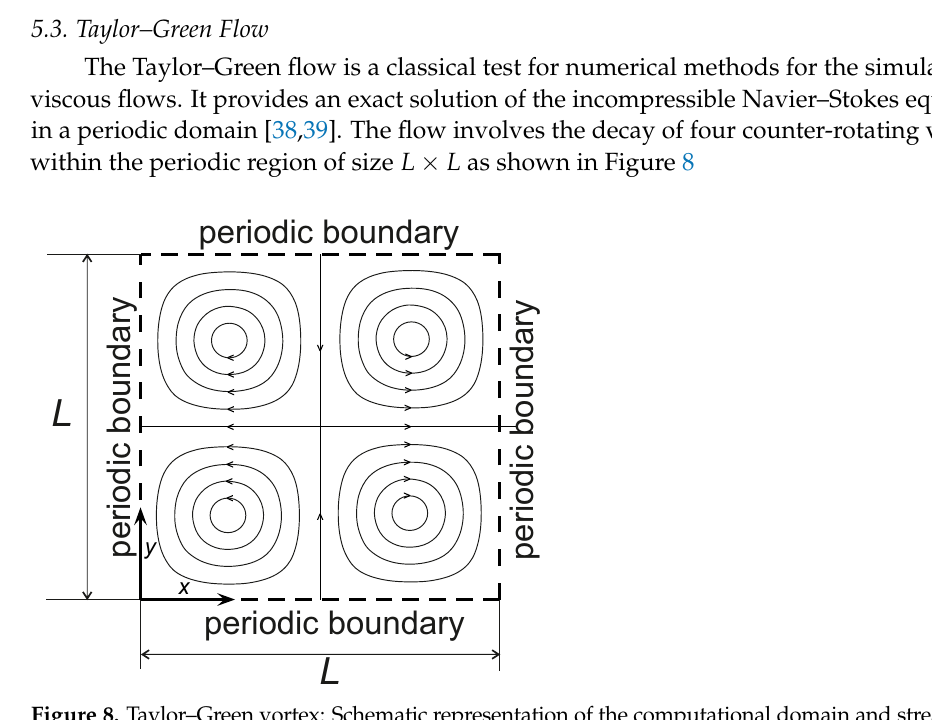
Figure 7. 2D Blast Explosion: Density profile along radial coordinate at time t final = 10 − 5 s. Radial distribution ( top left ), Delaunay distribution ( top right ), Random distribution ( bottom ).